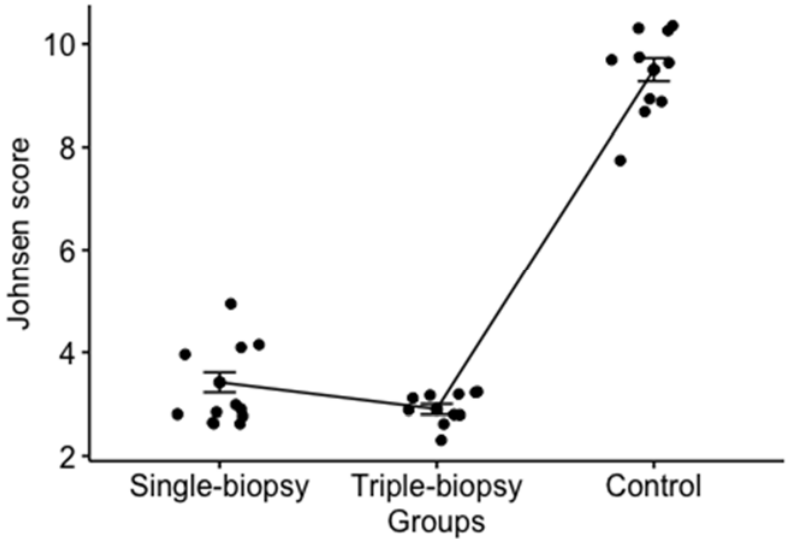
Figure 8. The Johnsen score value difference for the left testicle between the experimental groups (Kruskal-Wallis test; p < 0.001). Table 2. Comparison between left (punctured) and right (intact) testicles in single and triple-biopsy groups.